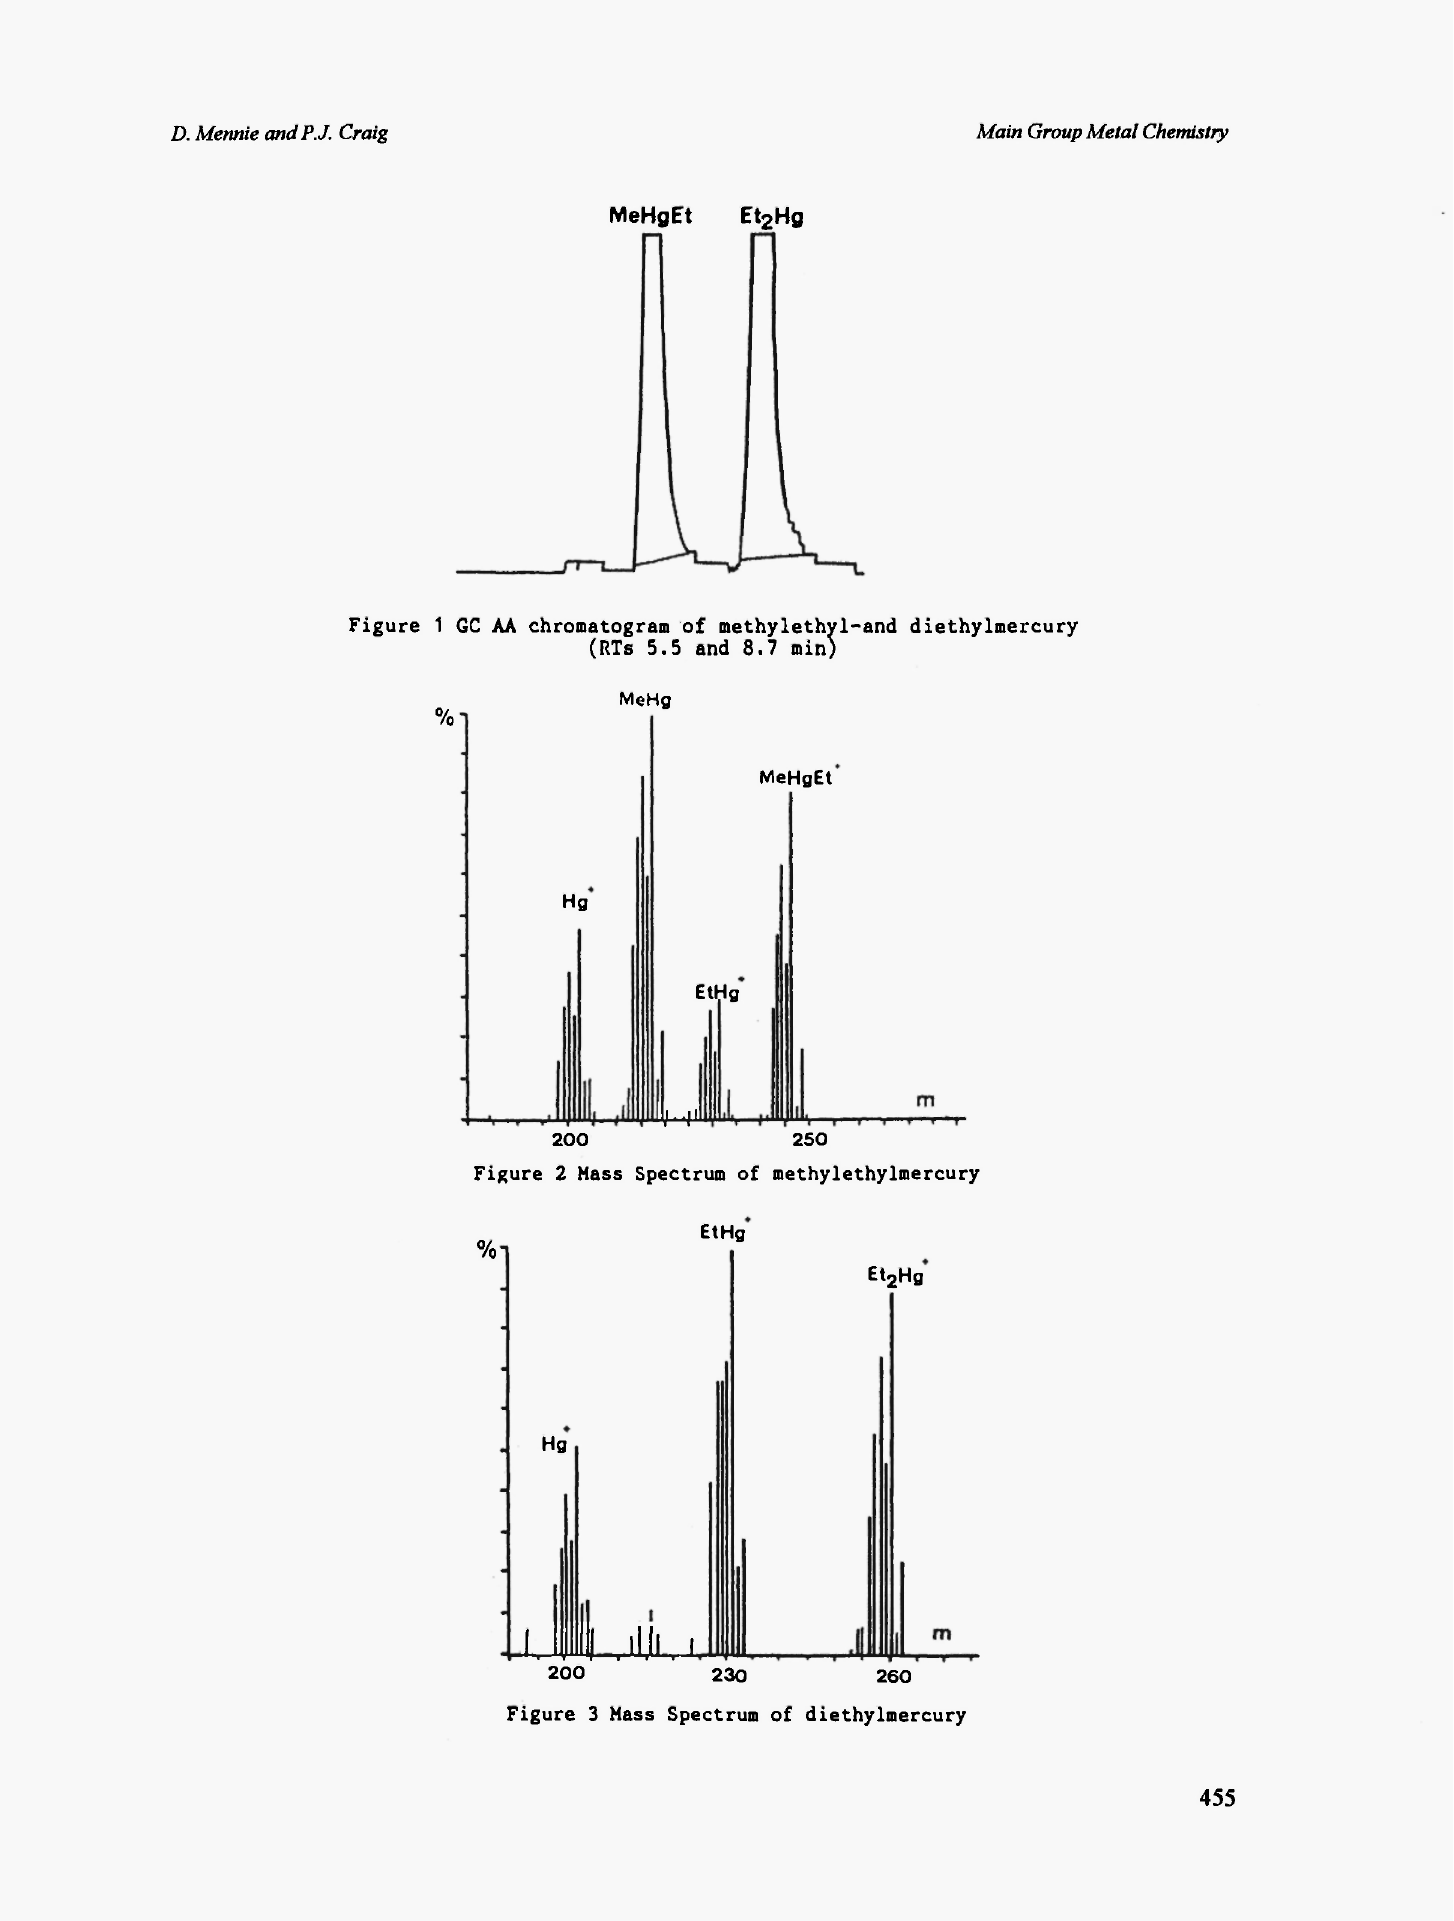
Figure 3 Mass Spectrum of